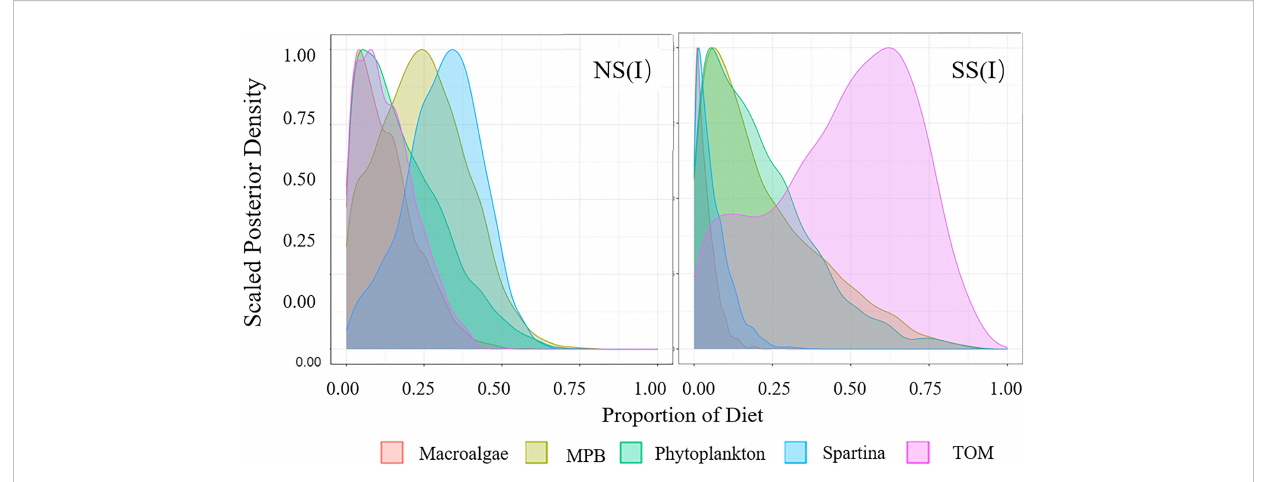
FIGURE 3 Diet proportion of fi lter-feeding fi sh. (I) Flood season; (II) Non- fl ood season; (NS) Northern shore; (SS) Southern shore.